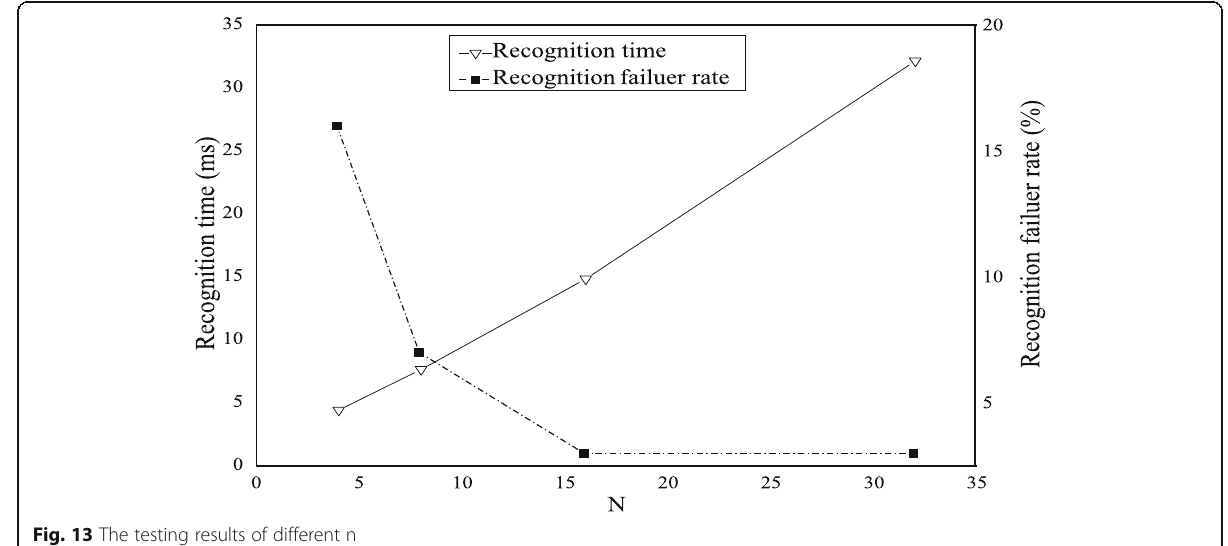
Fig. 13 The testing results of different n